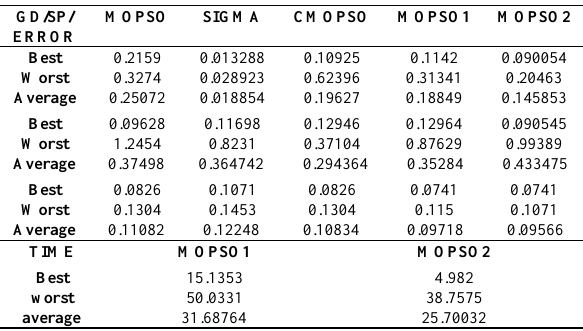
Table 1: GD/SP/ERROR/TIME result for first function. GD/SP/